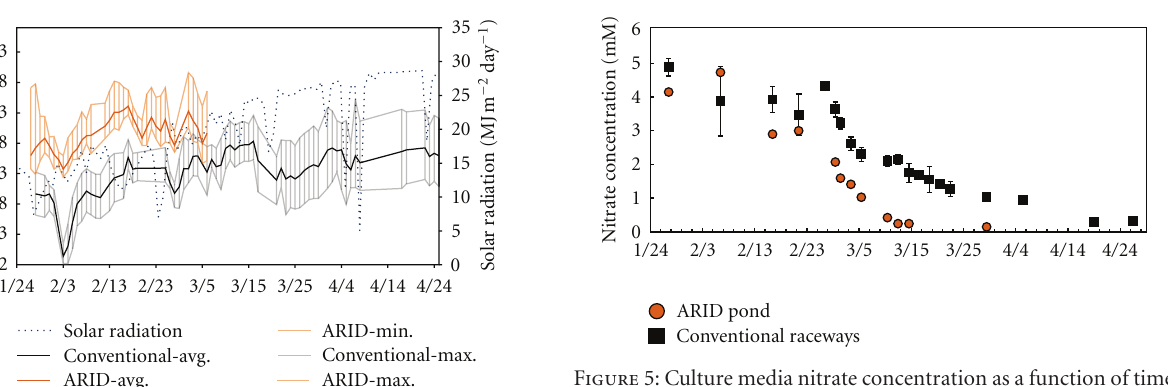
Figure 5: Culture media nitrate concentration as a function of time for the ARID pond and triplicate conventional raceways.